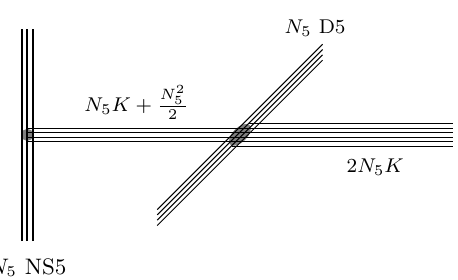
Figure 8. Brane configuration for semi-infinite D3-branes ending on a combination of N 5 D5- branes and N 5 NS5-branes. These are the non-gravitating bath solutions of [11].